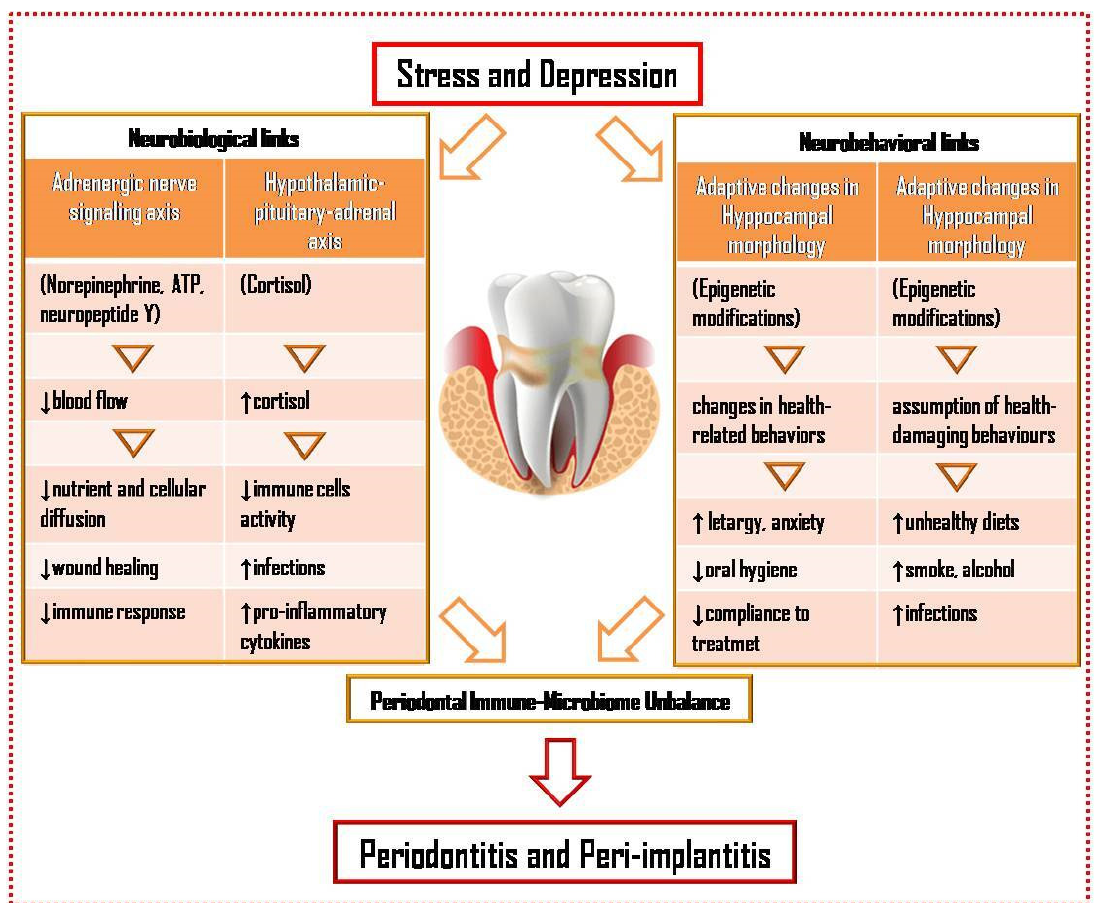
Figure 1. Neurobiological and neurobehavioral links and periodontal immune–microbiome unbalance in the possible association between chronic stress, depression and periodontal and peri-implant diseases.